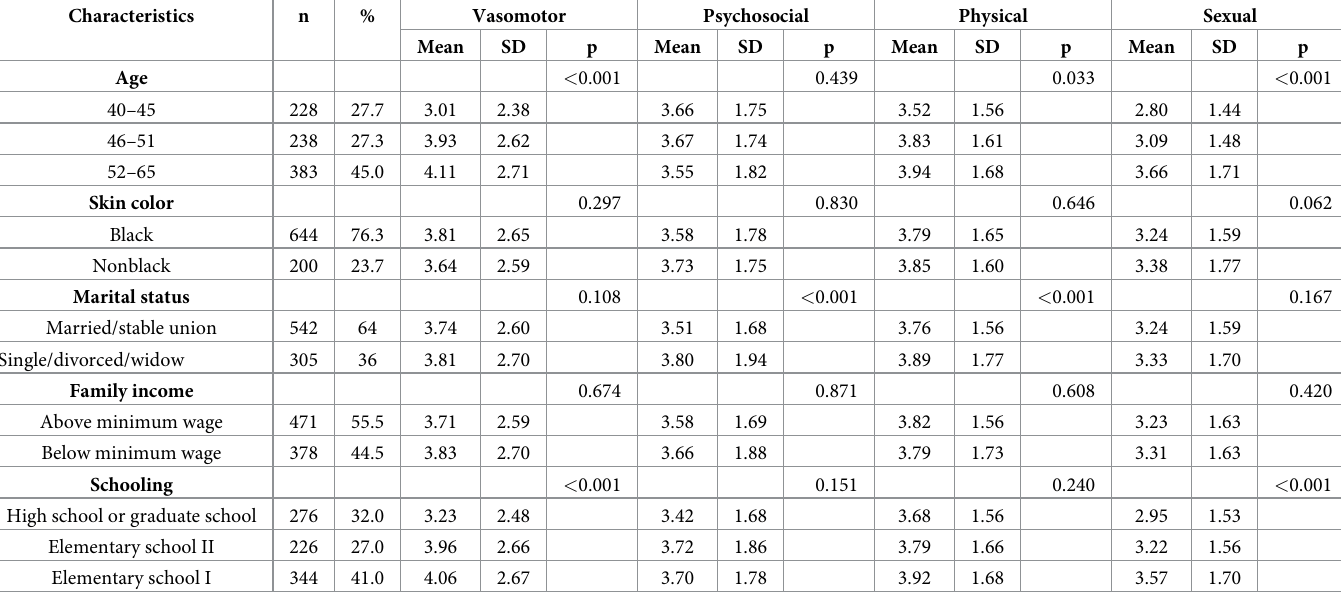
Table 3. Demographic and socioeconomic characteristics of climacteric women assisted by primary health care according to MENQOL domains,